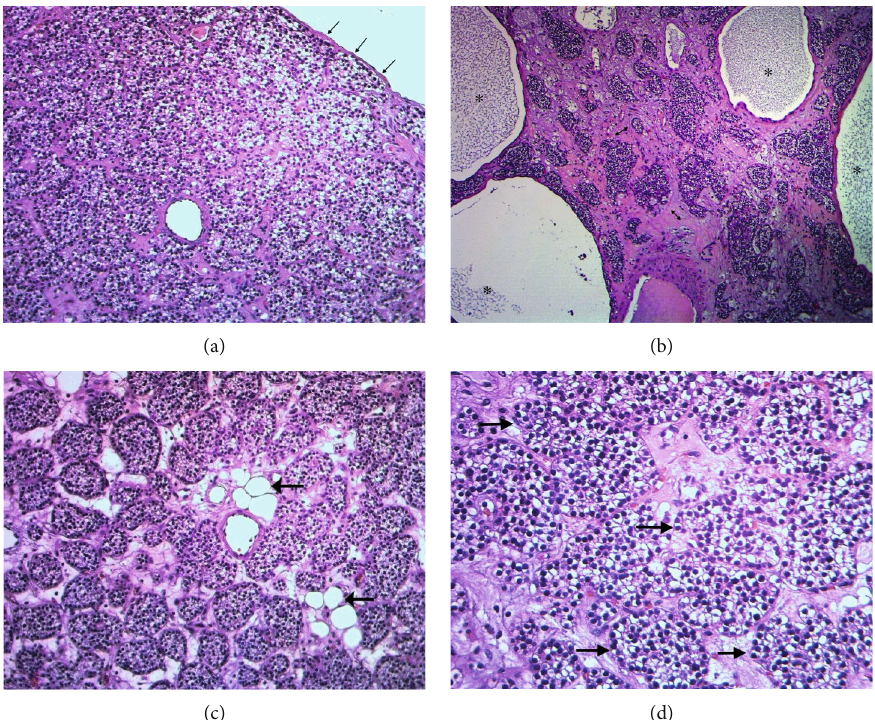
Figure 3: (a) Photomicrograph featuring thin fi brous capsule (arrows) and clusters and nests of chief epithelial cells with clear cytoplasm and rounded monotonous nuclei. The stroma shows vascularized connective tissue (H&E X 40). (b) Photomicrograph featuring tumor nests within fi brotic stroma (double headed arrows) with adjacent cystic areas (asterisk) surrounded by clusters of tumor cells. The cysts are fi lled with granular secretions. No necrotic tissue is present (H&E X 40). (c) Histological section of parathyroid adenoma featuring clusters and nests of benign epithelial cells with uniform rounded nuclei and water clear cytoplasm. The stroma contains few fat cells (arrows) (H&E X 200). (d) Histological section of parathyroid adenoma featuring clusters and nests of benign epithelial chief cells (arrows) with uniform rounded nuclei and water clear cytoplasm (H&E X